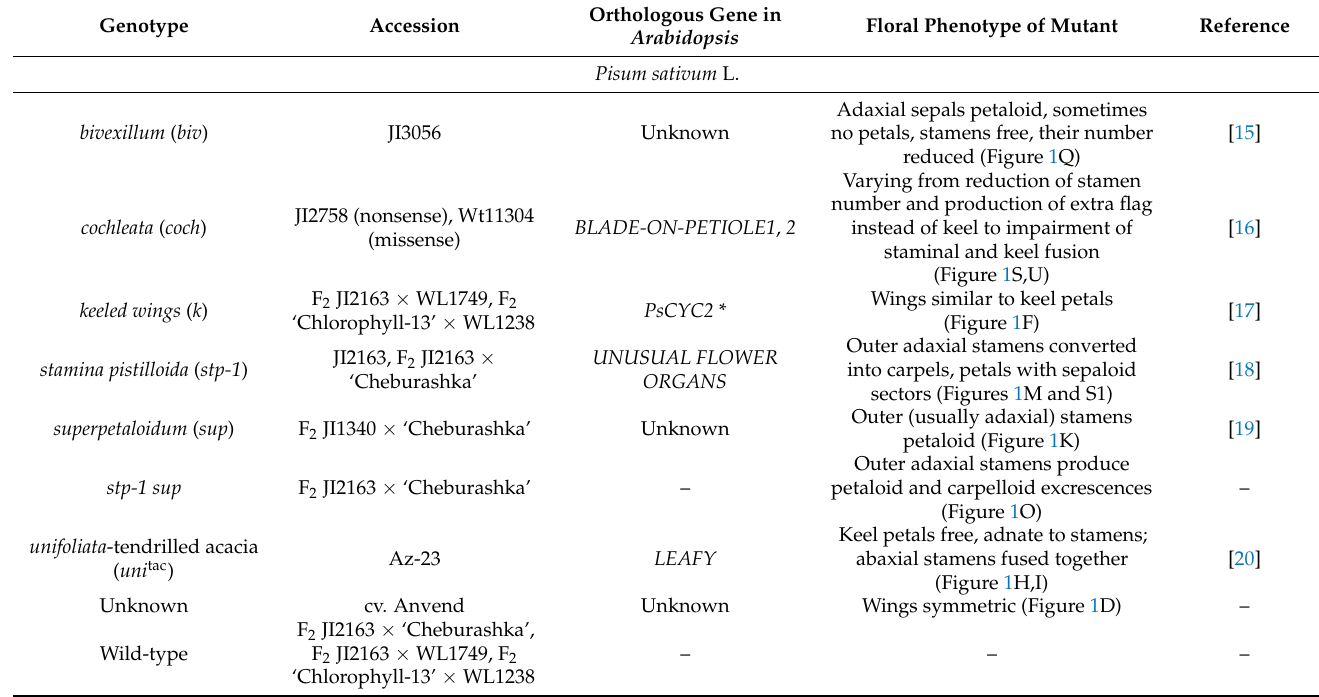
Table 1. Plant material used for the